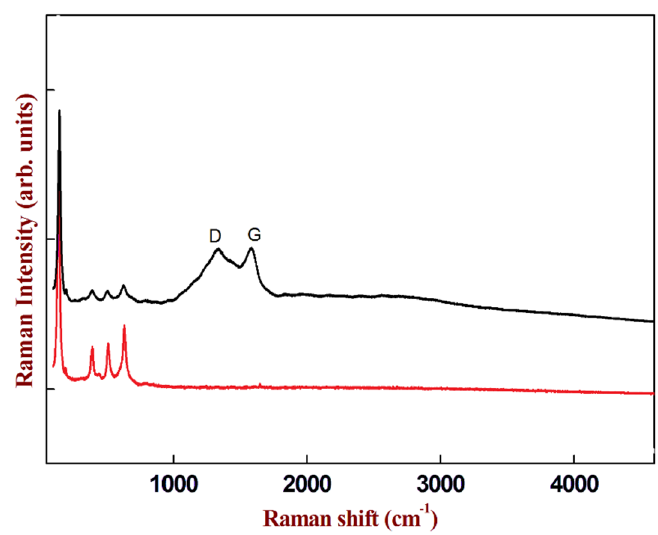
Figure 3. Raman spectra of the p-C / TiO 2 specimen prepared at a temperature of 600 ◦ C (black curve) and of pristine (neat) P25 TiO 2 (red curve).